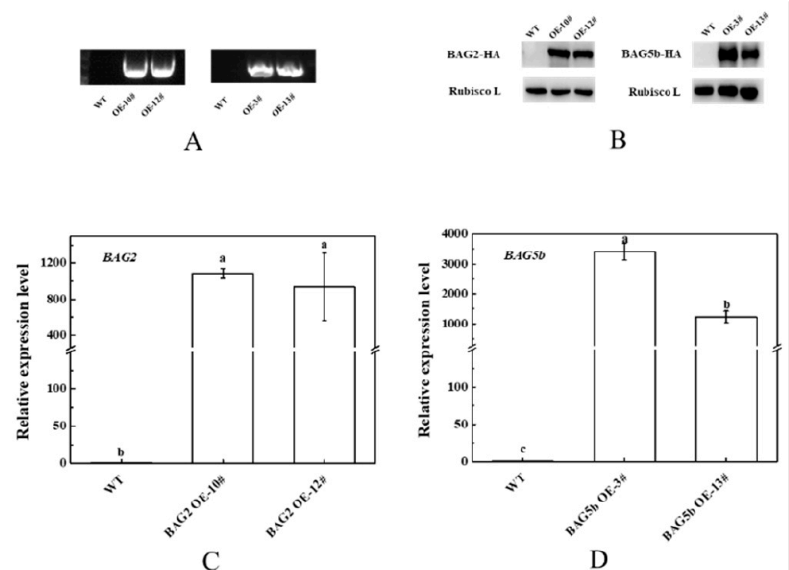
Figure 8. Overexpression of BAG2 and BAG5b in transgenic tomato. ( A ): Genome PCR; ( B ): Western blot; ( C , D ): qPCR test. OE − 10# and OE − 12# were two independent samples of plants overexpressing BAG2 . OE − 3# and OE − 13# were two independent samples of plants overexpressing BAG5b . For each gene, the expression level of the WT plant was set as 1.0. Different letters indicate expression levels that were significantly different at P <